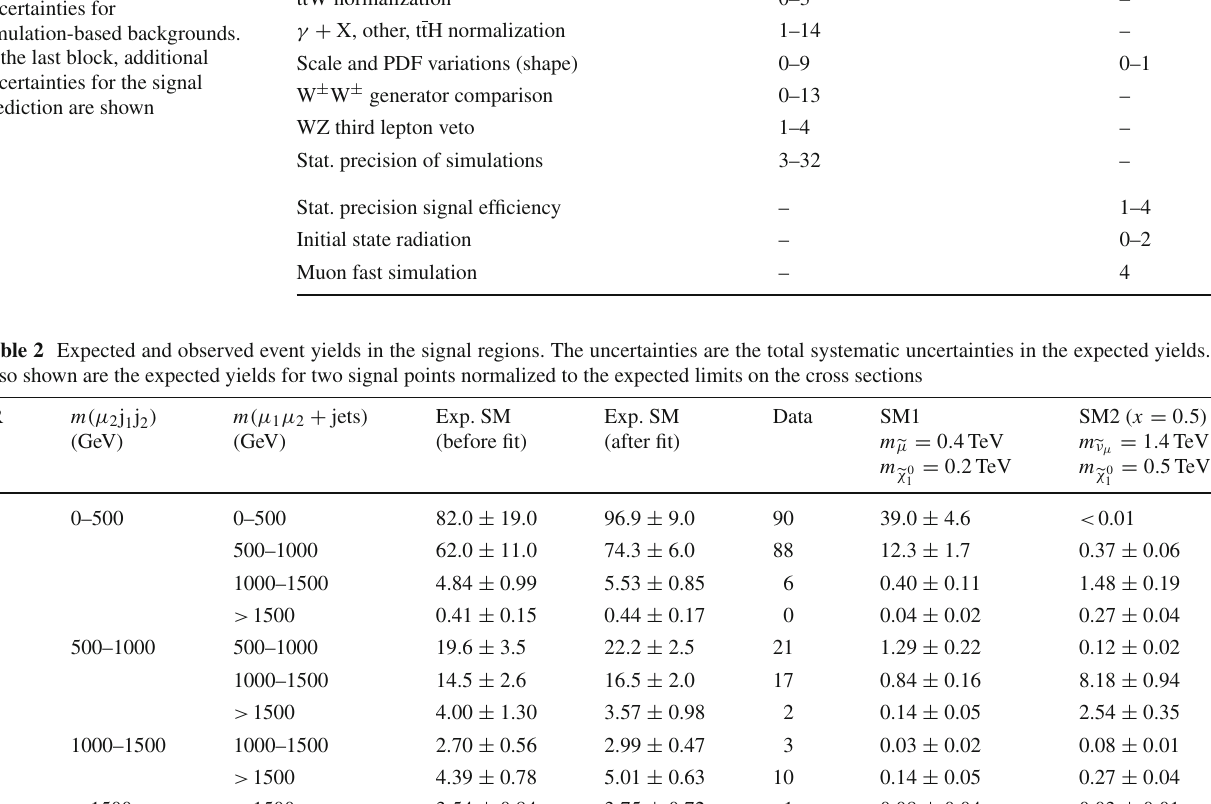
Table 1 Sources of systematic uncertainties considered in this search and the range of yield variations in the signal regions. The background uncertainties are given as fractions of the total background yields in the signal regions. For the signal, the ranges covering the most relevant signal regions for each signal are given. The first three blocks affect the background predictions and list all experimental uncertainties, uncertainties for processes where the yield is obtained from data, and additional uncertainties for simulation-based backgrounds. In the last block, additional uncertainties for the signal prediction are shown